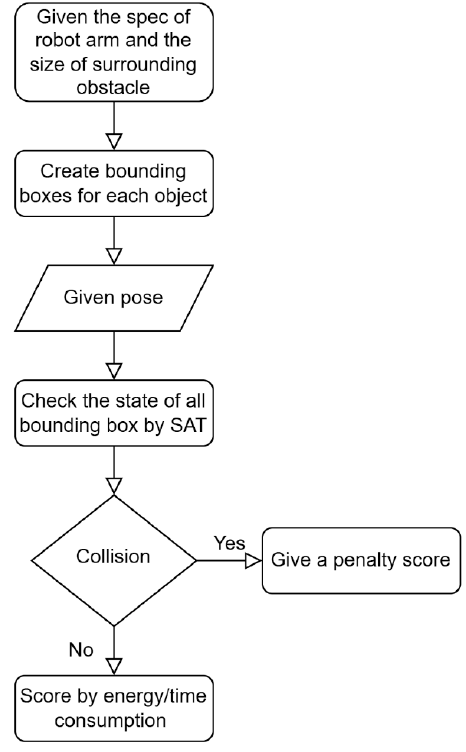
Figure 3. The flow chart of the self-collision detection.